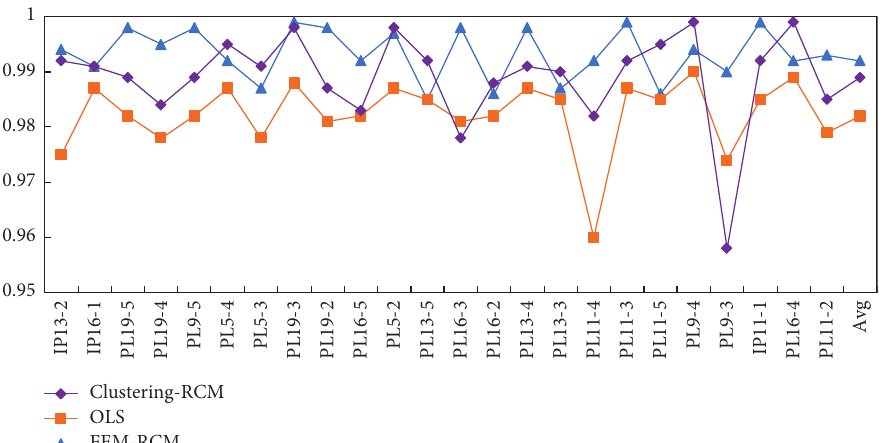
Figure 12: Comparing the correlation coefficient R of the FEM-RCM model with the clustering-RCM model and statistical model using OLS